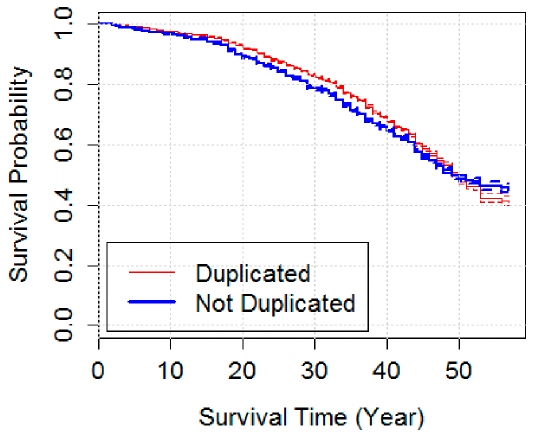
Figure 6. Comparison of the Kaplan–Meier (KM) curve with and without redundant data.